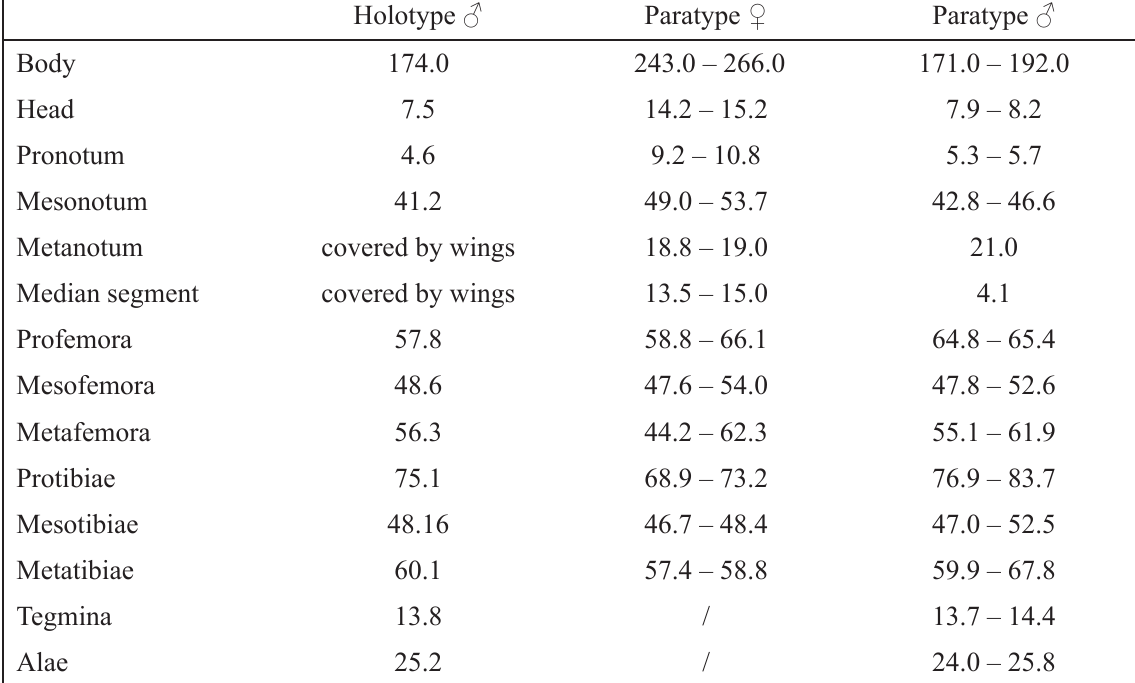
Table 4. Measurements (mm) of Phobaeticus trui sp.